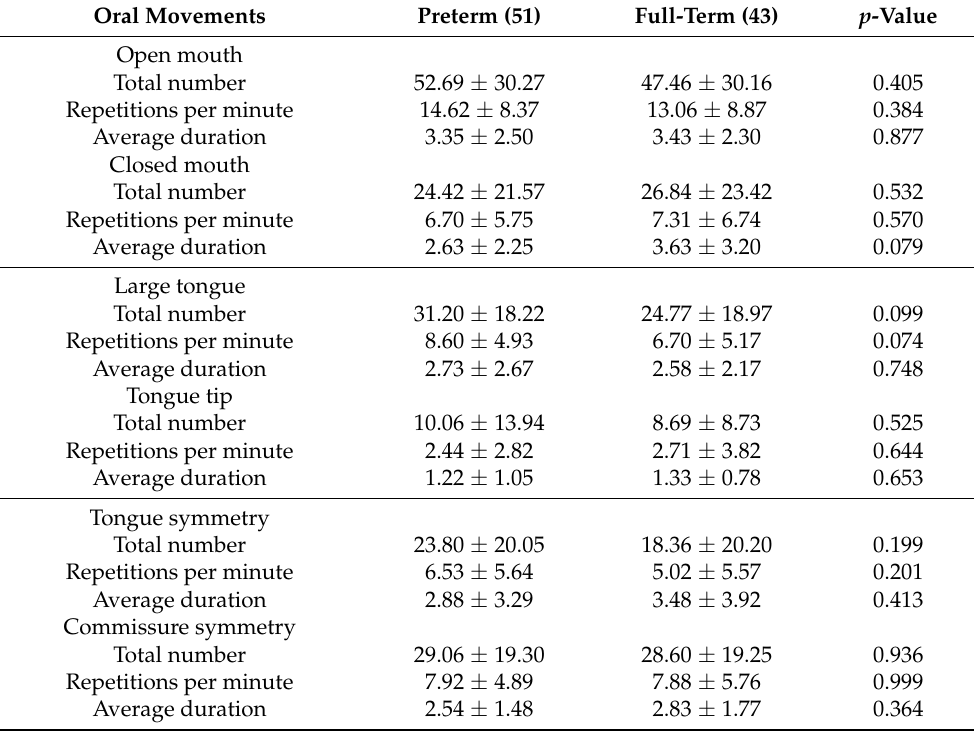
Table 3. Records of oral movements (means and standard deviations) for all preterm and all full-term infants. Oral Movements